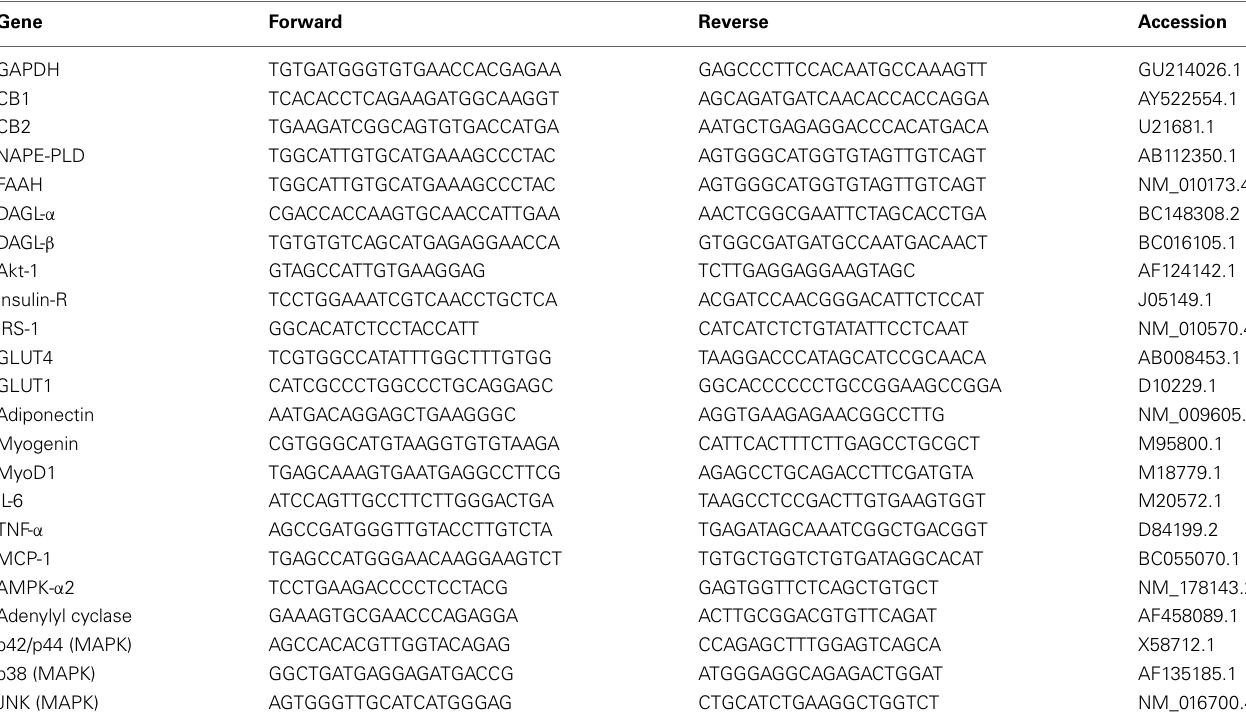
Table 1 | Primer sequences used for quantitative polymerase chain reaction (qPCR).